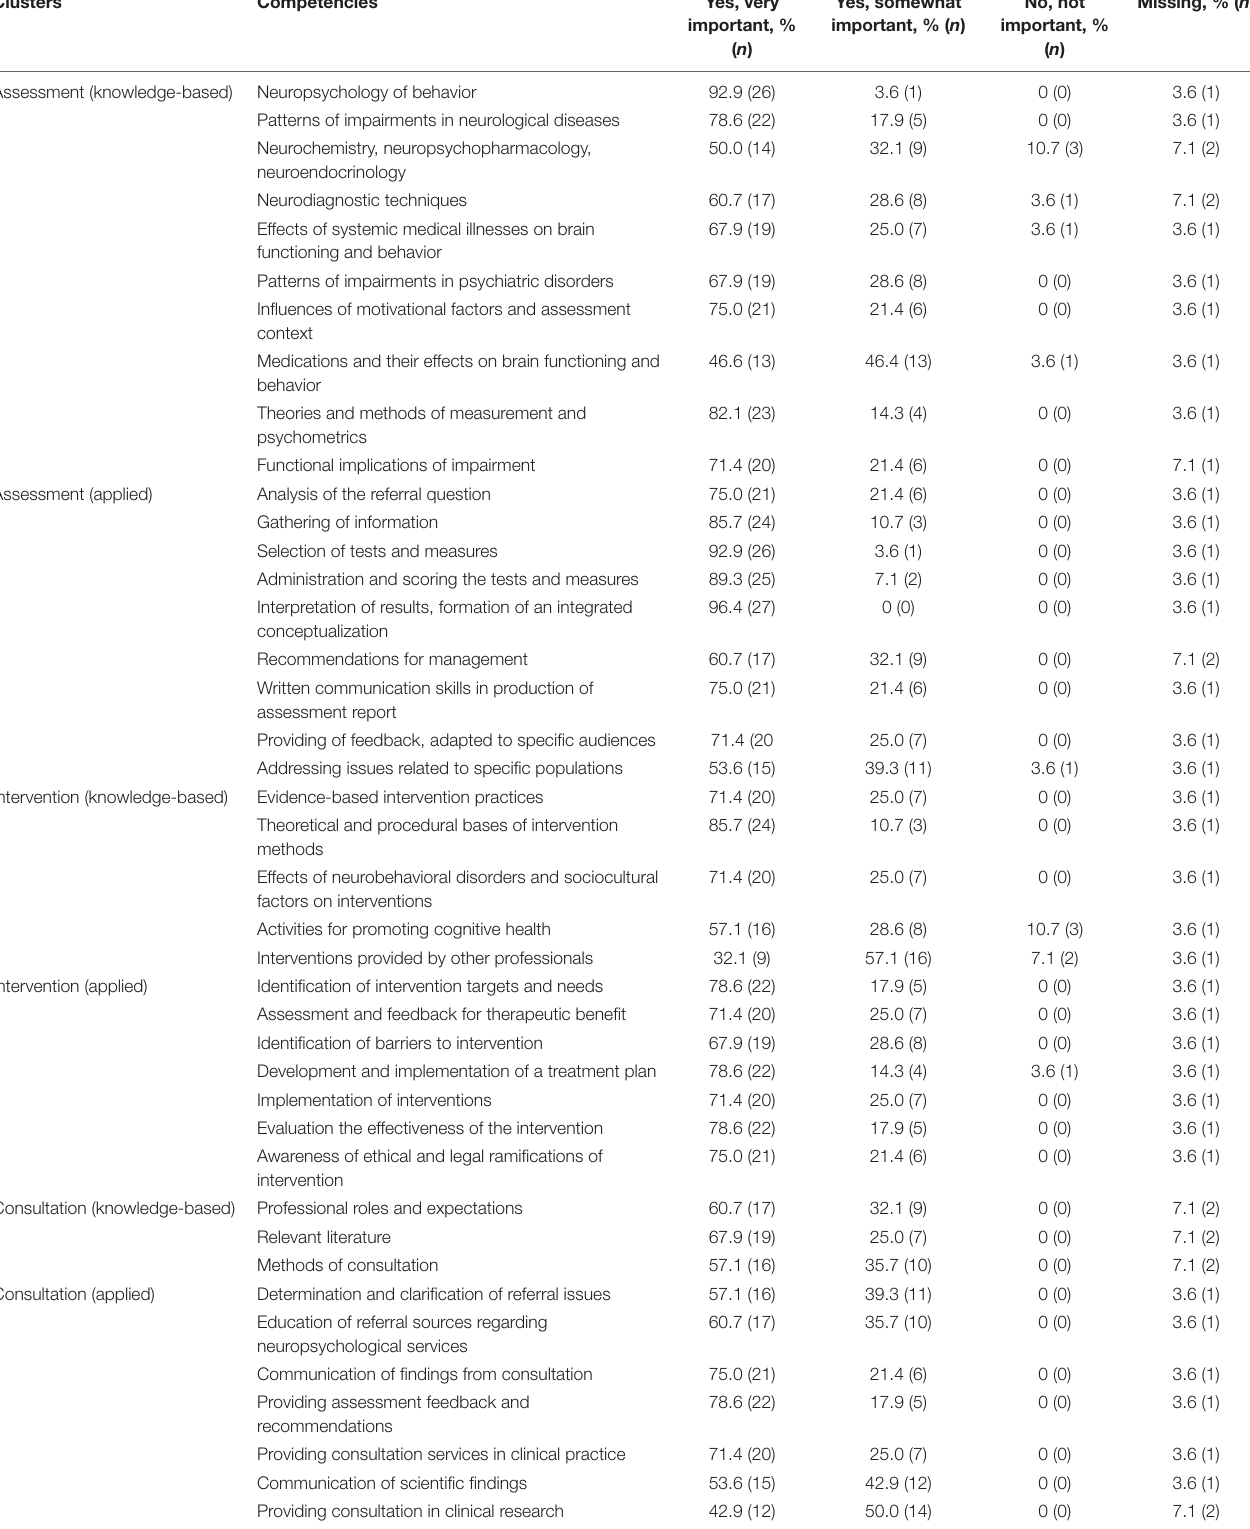
TABLE 2 | Percentage of respondents giving an affirmative or negative response on items pertaining to foundational knowledge-based and applied competencies unique to clinical neuropsychology: ratings given as yes, very important, yes somewhat important, or no, not important. Clusters